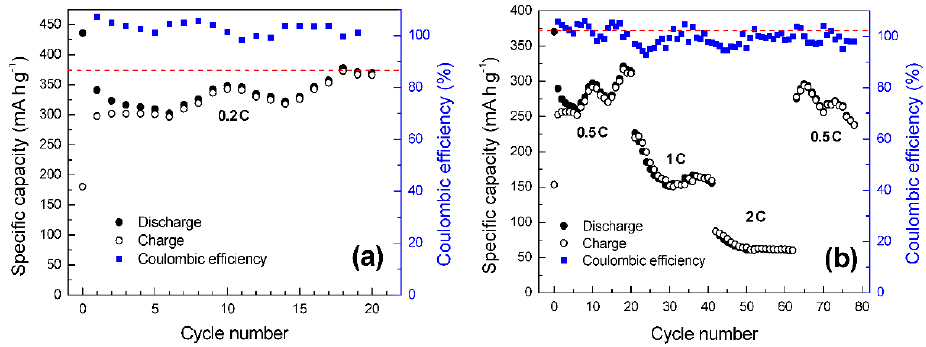
Figure 11. ( a ) Cycling performance at a current density of 74 mA g − 1 (0.2C) of a Li-ion battery using recycled graphite CL 1 BM as anode material. The red dashed line indicates the theoretical capacity of graphite (372 mA h g − 1 ). ( b ) Rate performance.